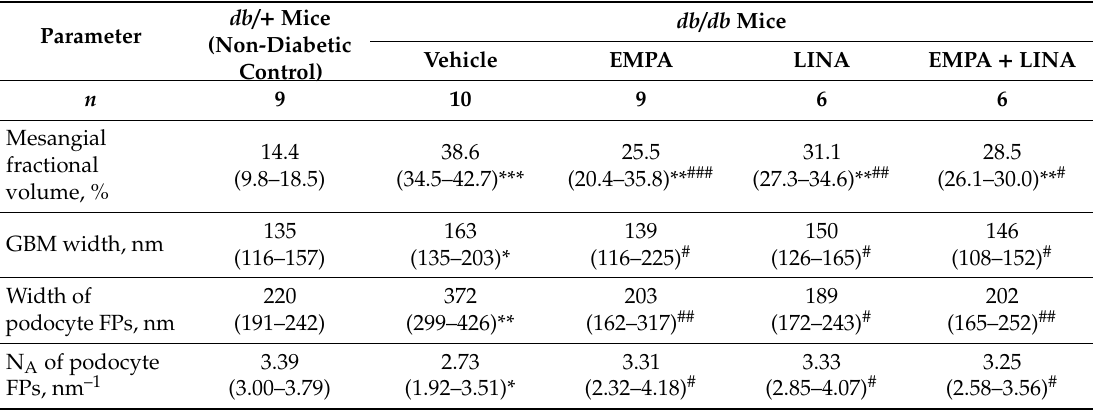
Table 4. Glomerular structural parameters in db /+ and db / db